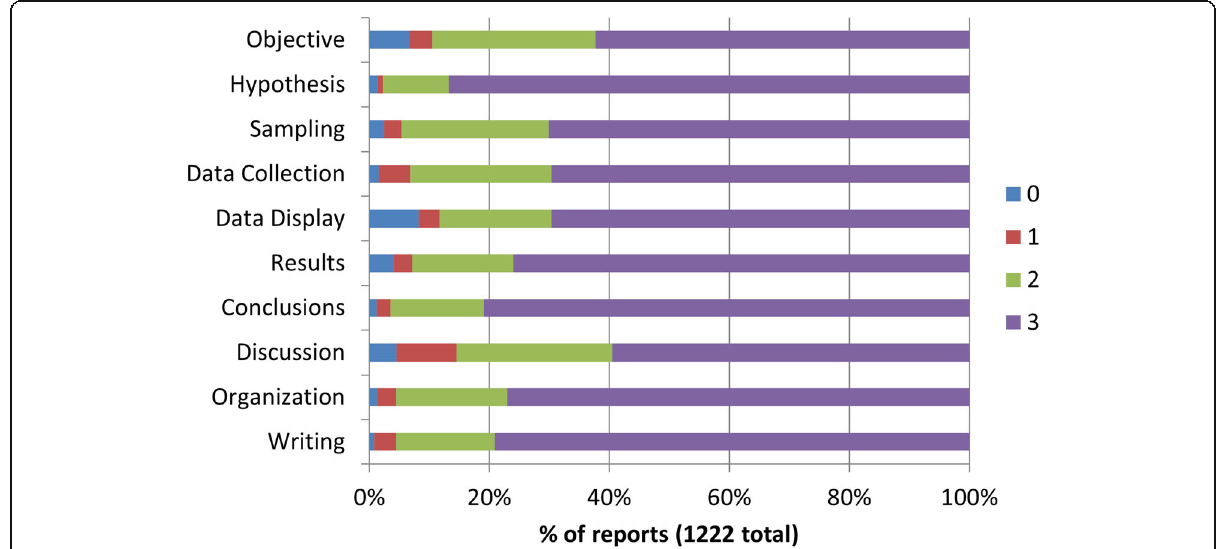
Fig. 7 Scores of students ’ inquiry reports. Distribution of scores, 0 (meeting none of the three criteria) to 3 (meeting all three criteria), for each of the 10 categories of the rubric for the inquiry